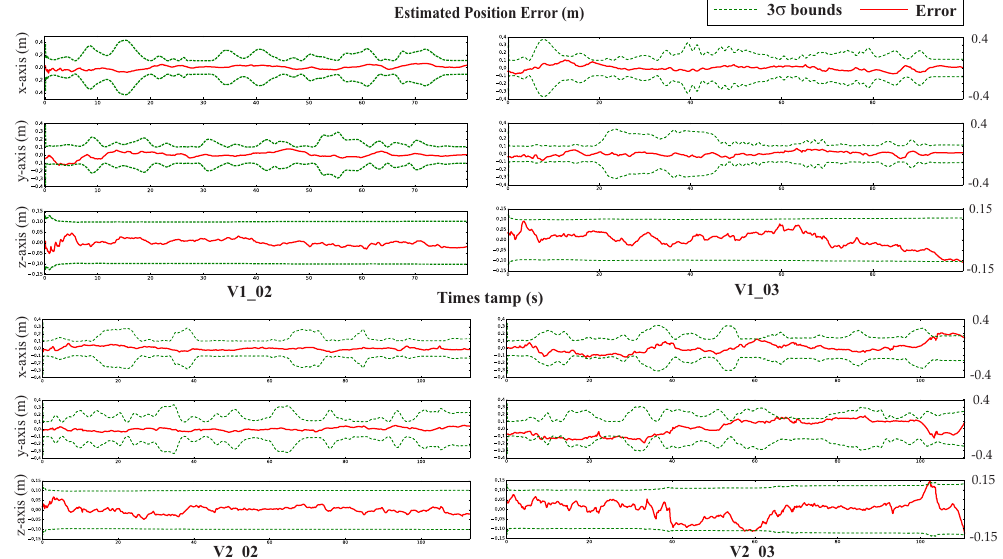
Figure 10. State estimation errors (red-line) and 3 σ bounds (green-dashed line) for the proposed